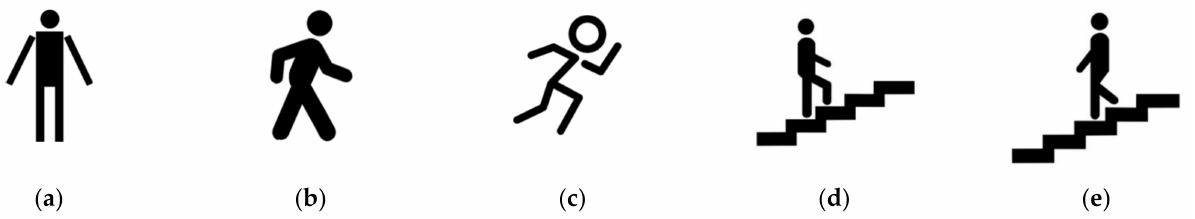
Figure 2. Schematic diagram of multi-motion modes. ( a ) Static; ( b ) Walking; ( c ) Running; ( d ) Going upstairs; ( e ) Going